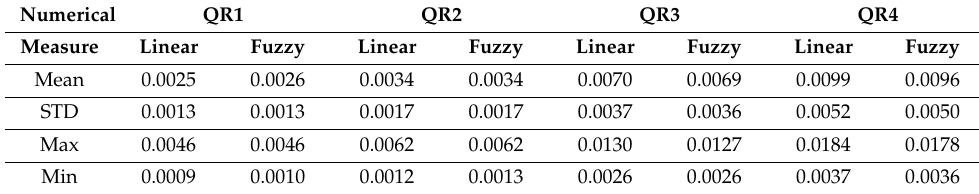
Table 5. Numerical measures of J T for 10